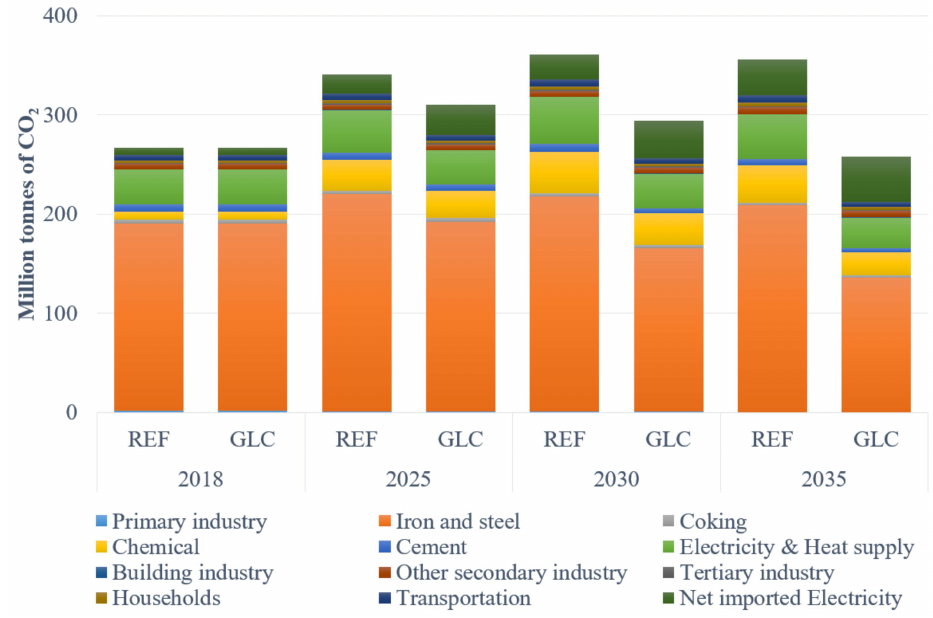
Figure 7. Prediction of CO 2 emissions from critical sectors.